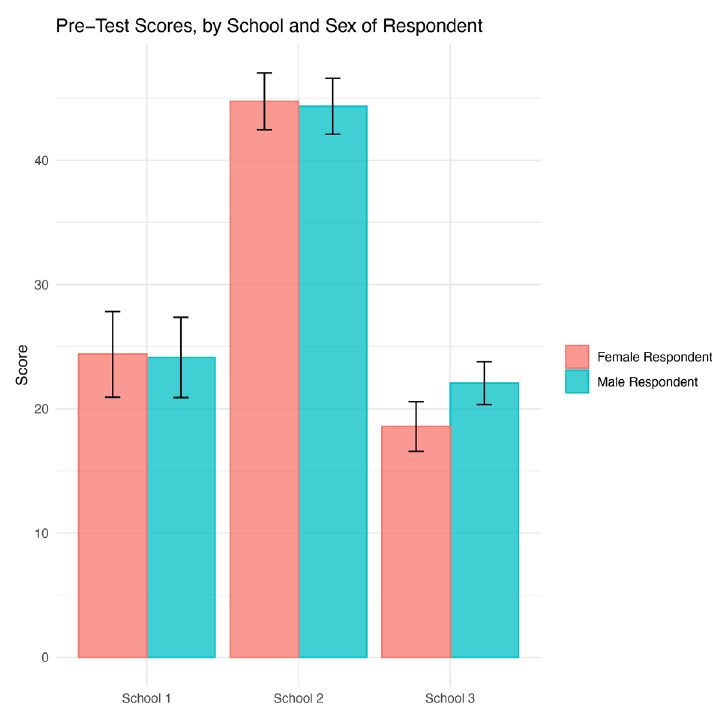
Figure 6. Pre-test scores by school and sex of respondent. Bars represent the standard error of the mean.